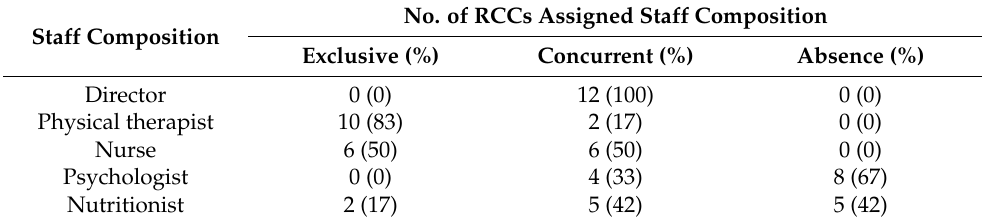
Table 6. Staff Composition for Cardiac Rehabilitation Program in 12 RCCs.